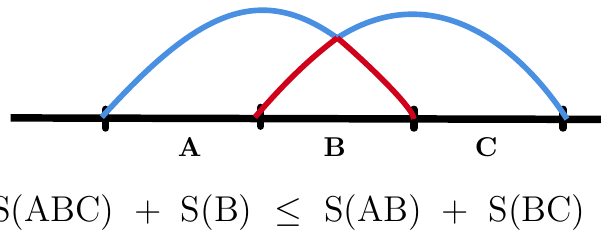
Figure 5 . Cutting and pasting proof of Strong Subadditivity. The union of the blue and red curves has length S ( AB ) + S ( BC ) . But the blue curve ends on ABC , and thus has length at least S ( ABC ) , while the red curve ends on B , and thus has length at least S ( B ) .